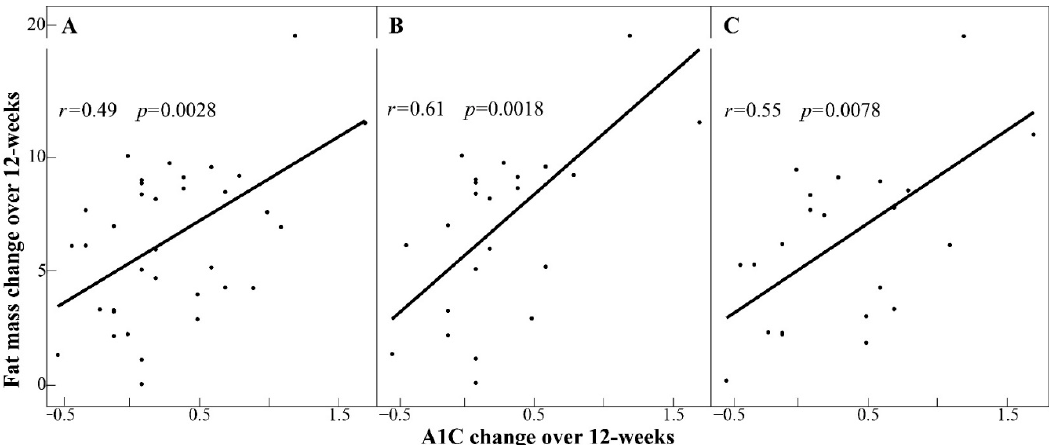
Figure 2. Changes in fat mass and glycated hemoglobin associated in participants with higher BMI and android:gynoid fat. Scatter plots with regression line showing decrease from baseline to Week 12 ( r , Pearson’s coefficient): ( A ) all participants; ( B ) higher body mass index group (HI BMI ); and ( C ) higher android:gynoid fat group (HI AG ). The corresponding low groups for BMI and AG did not show similar association.